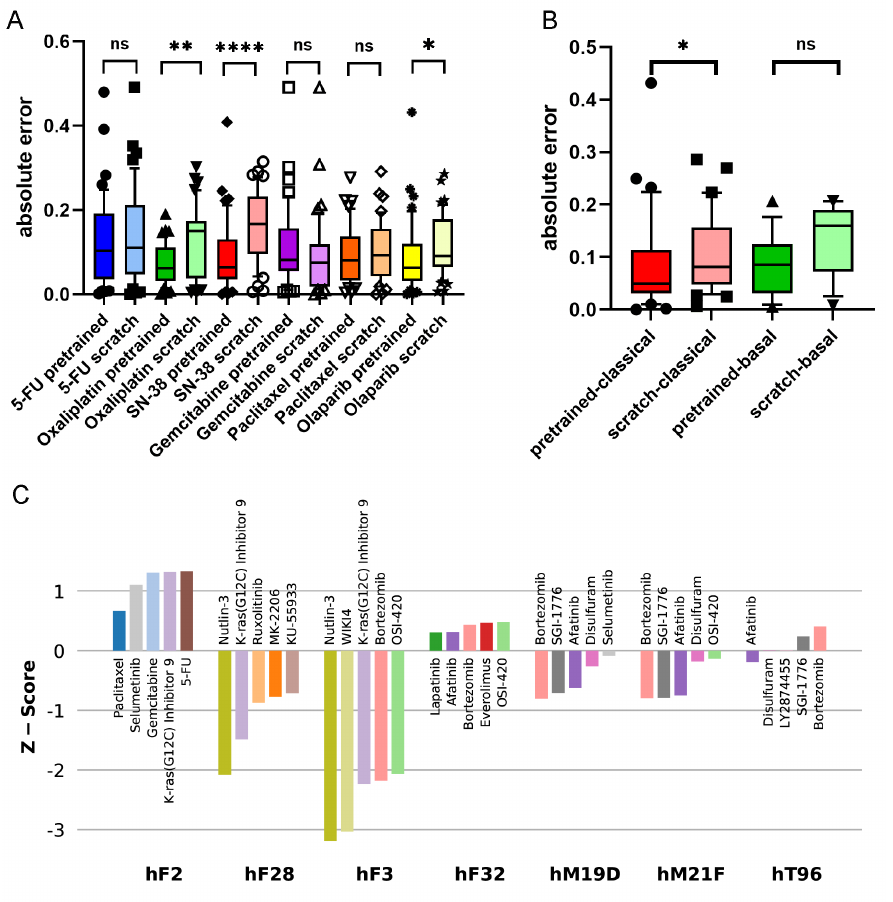
Figure 3. Effect of pre-training for PDO–drug AUC predictions. ( A ) Absolute differences in predicted and ground truth AUCs (y-axis) for standard therapies with pre-trained and models trained from scratch (x-axis). Boxes show the 10–90% ranges of absolute errors for the different PDOs; the line within each box depicts the median value. Bright colors show the pre-trained models; lighter colors show the trained-from-scratch models. On top of each model pair, the result of an unpaired, two- sided Mann–Whitney test is displayed (****: p < 0.0001; **: p < 0.01; *: p < 0.05; ns: not significant). ( B ) Absolute differences in predicted and ground truth AUCs (y-axis) for the targeted drug olaparib when PDOs are grouped according to basal and classical subtypes. On top of each model pair, the result of an unpaired, two-sided Mann–Whitney test is displayed (****: p < 0.0001; **: p < 0.01; *: p < 0.05; ns: not significant). ( C ) Z -scores (y-axis) of the 5 best drug predictions for selected PDOs (x-axis). Different drugs are indicated by colored